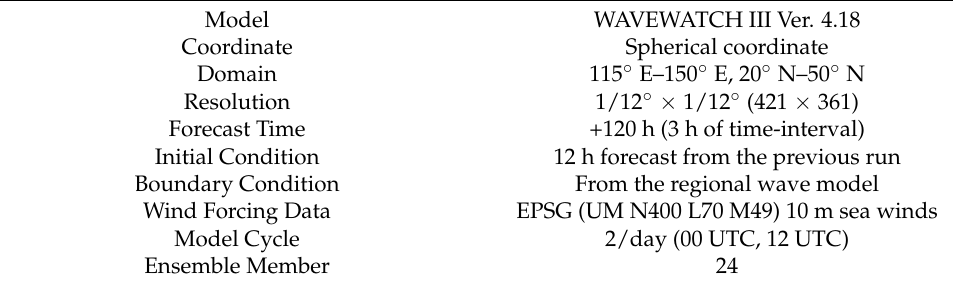
Table 1. Description of ensemble wave forecast